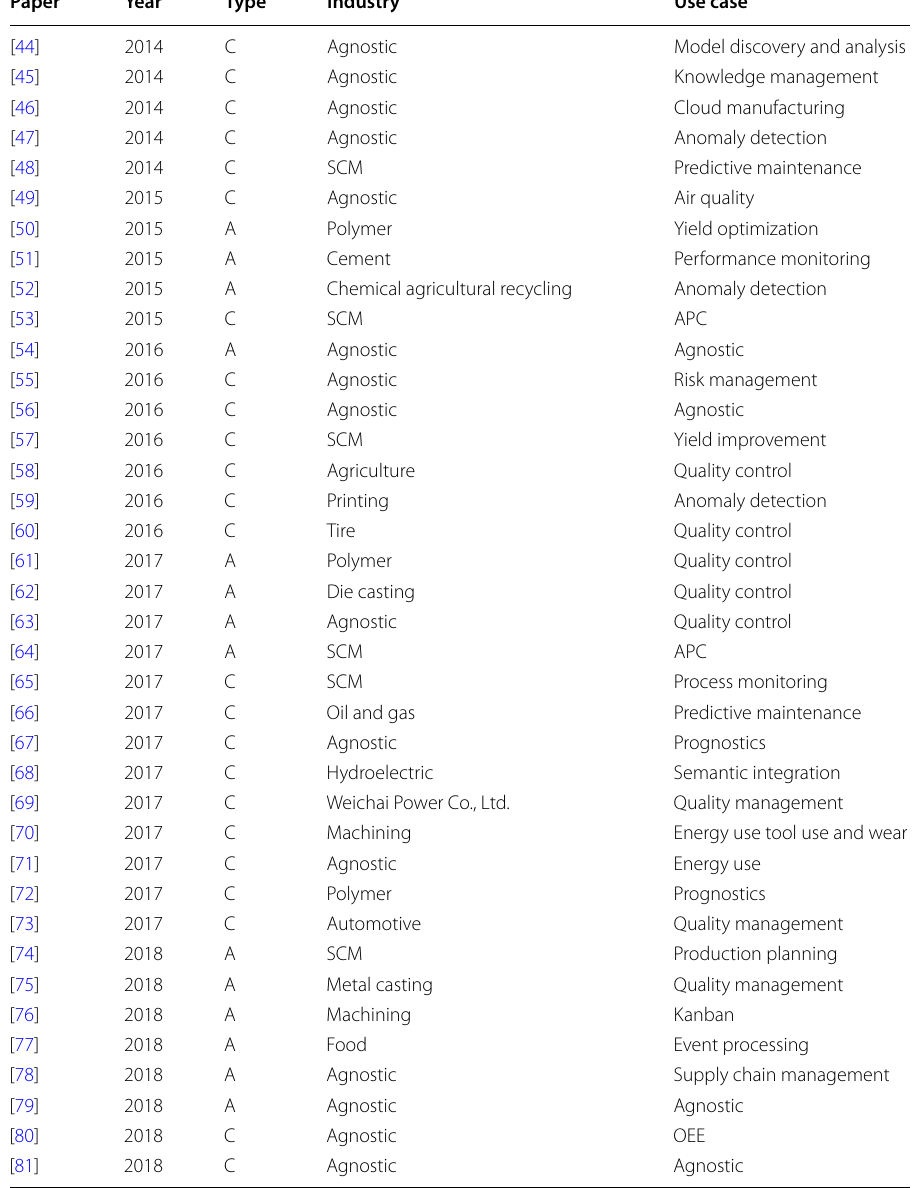
Type ‘C’ represents a conference paper and ‘A’ a journal article SCM: semi-conductor manufacturing, APC: advanced process control, OEE: overall equipment effectiveness